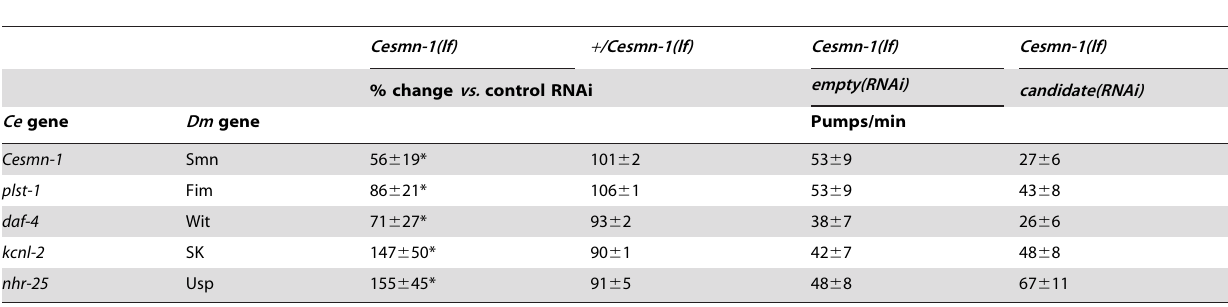
Table 3. RNAi knockdown of candidate genes alters Cesmn-1(lf) neuromuscular defects in the pharyngeal pumping